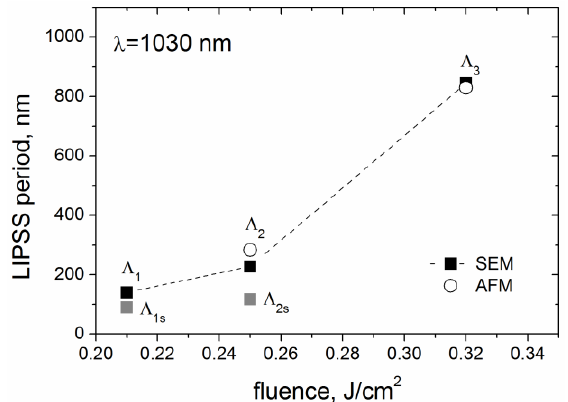
Figure 7. Period vs. fluence of the LIPSS formed on the DLN film during sub-threshold processing with IR fs-laser at the scanning velocity v s = 0.04 m/s.; designation of the LIPSS periods ( Λ 1, Λ 2 , etc.) is given in Figure 6.